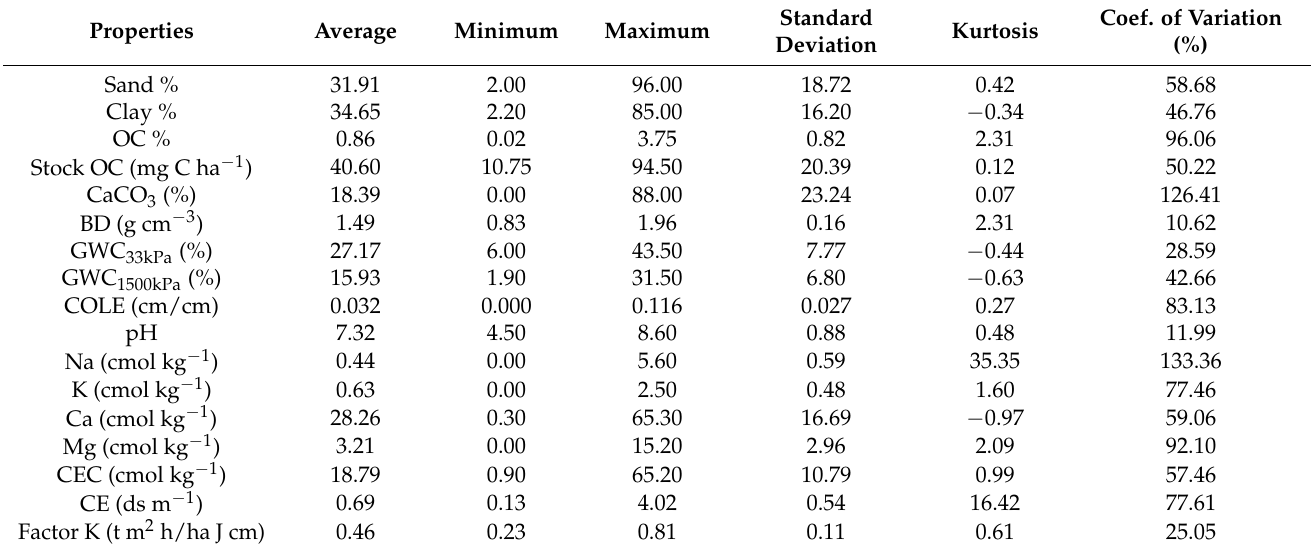
Table 2. Descriptive statistics of soil